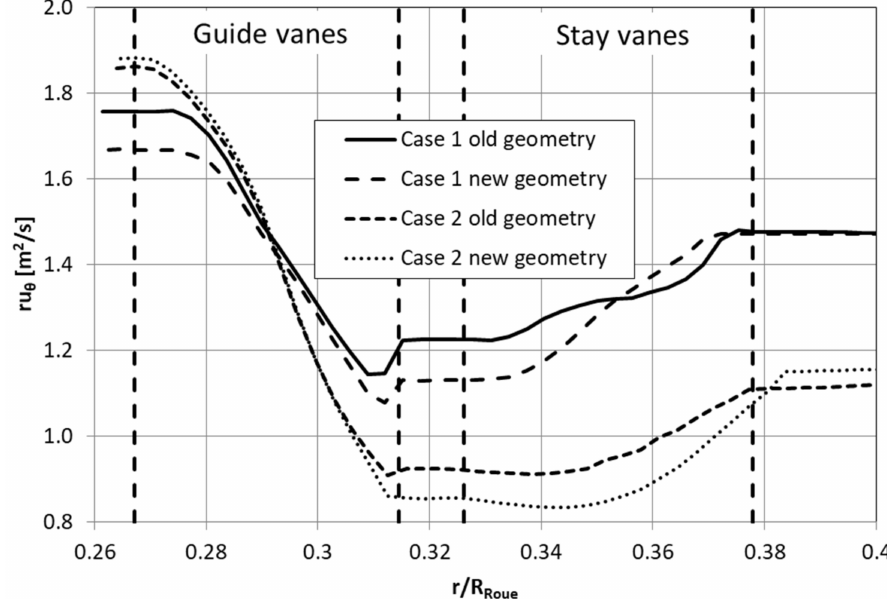
Figure 17. Angular momentum in function of the tandem cascade